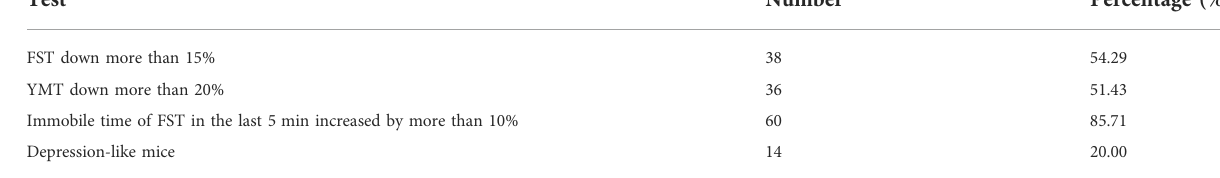
TABLE 1 CUMS-induced behavioral changes in the